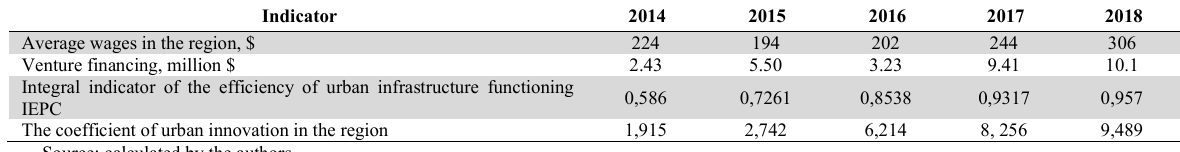
Indicators which are used to estimate the multiplier effect of the analysis of the effectiveness of urban infrastructure IPEC functioning (2014-2018).